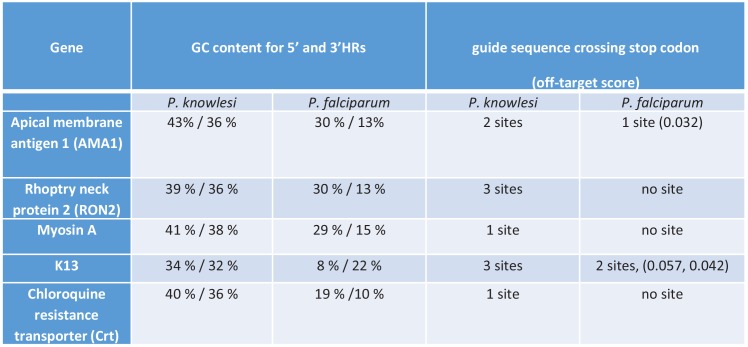
Comparison of P. knowlesi and P. falciparum 3D7 genes.Table showing comparison of P. knowlesi and P. falciparum guanine-cytosine content and Protospacer adjacent Motif (PAM) sites for five selected genes that were successfully targeted and tagged in P. knowlesi.